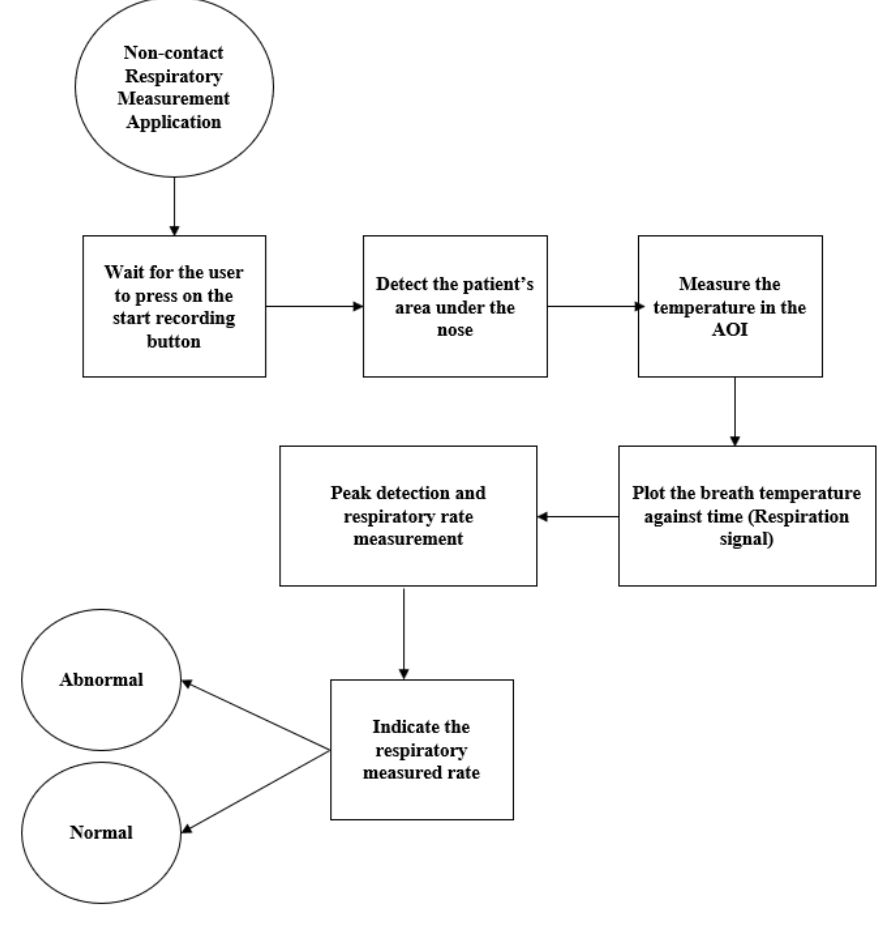
Figure 2. Mobile application workflow diagram.